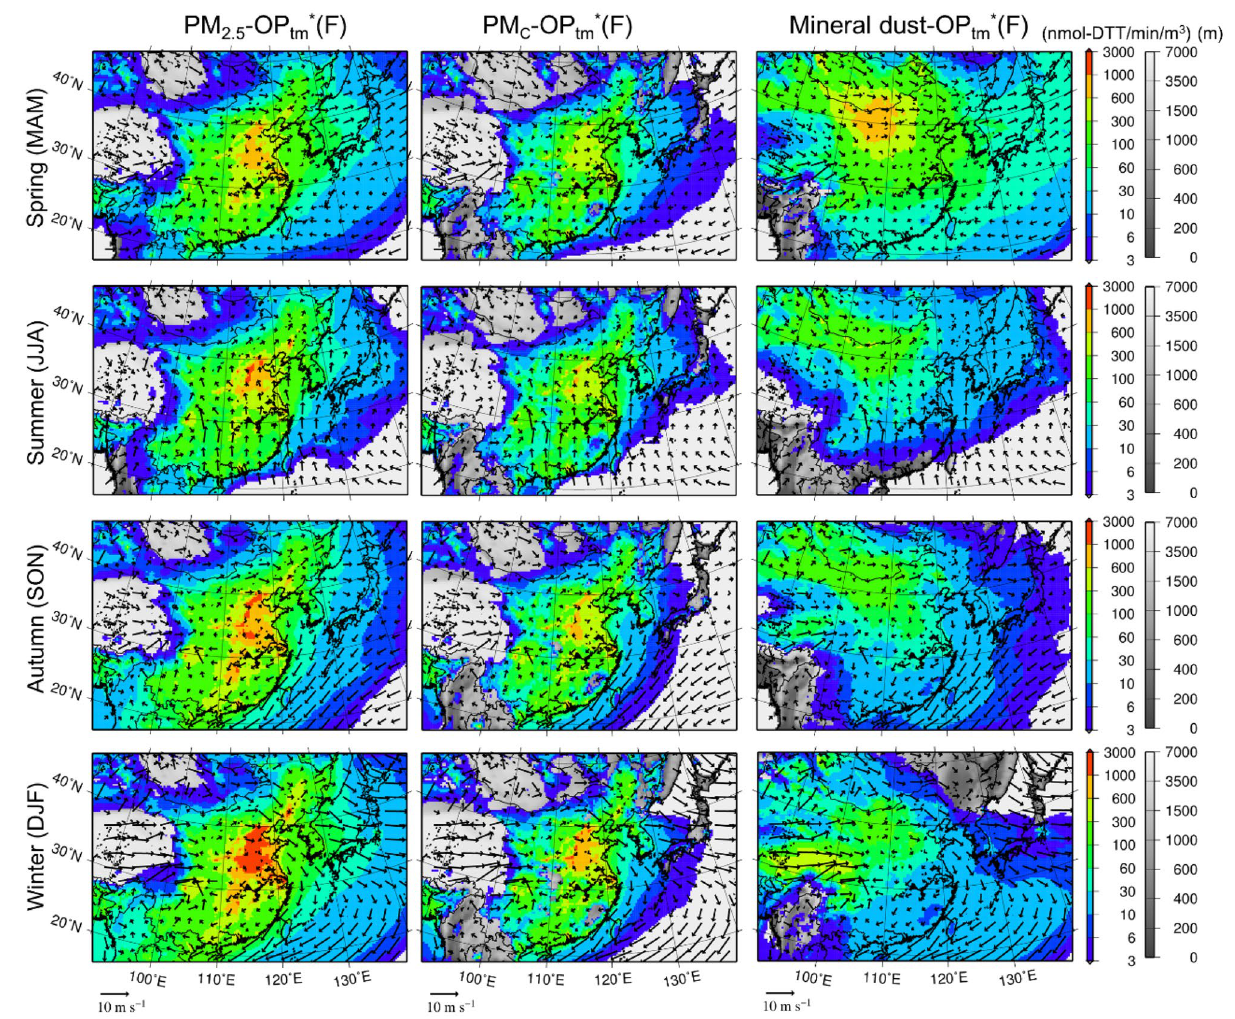
Figure 3. Seasonal mean surface OP tm *(F). Seasonal mean surface air concentrations of (left to right) anthropogenic PM 2.5 -OP tm *(F), anthropogenic PM c -OP tm *(F), and OP tm *(F) of Asian dust in (top to bottom) the spring, summer, autumn, and winter of 2013 with the surface wind vectors over D01. The model terrestrial elevations are depicted in grayscale under the various colors. The map was generated using the Generic Mapping Tools v4.5.7 (https:// www. gener ic- mappi ng- tools.